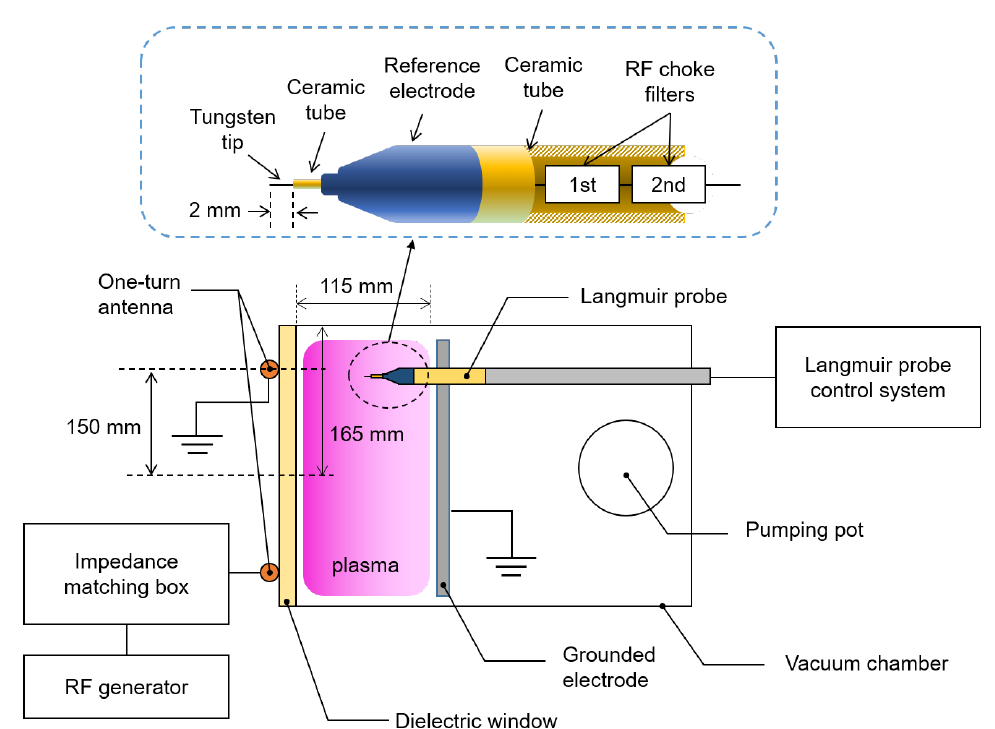
Figure 1. Schematic diagram of experiment setup involving an inductively coupled plasma source and Langmuir